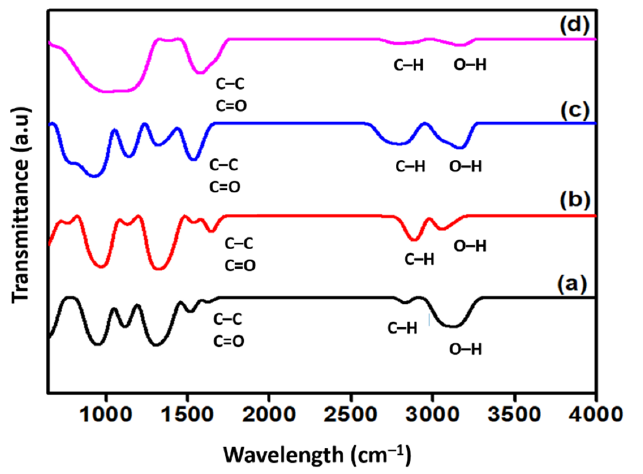
Figure 4. FTIR spectra of ( a ) commercial CNF and the surface ‐ oxidised ( b ) CNF ‐ MA; ( c ) CNF ‐ MB; and ( d ) CNF ‐